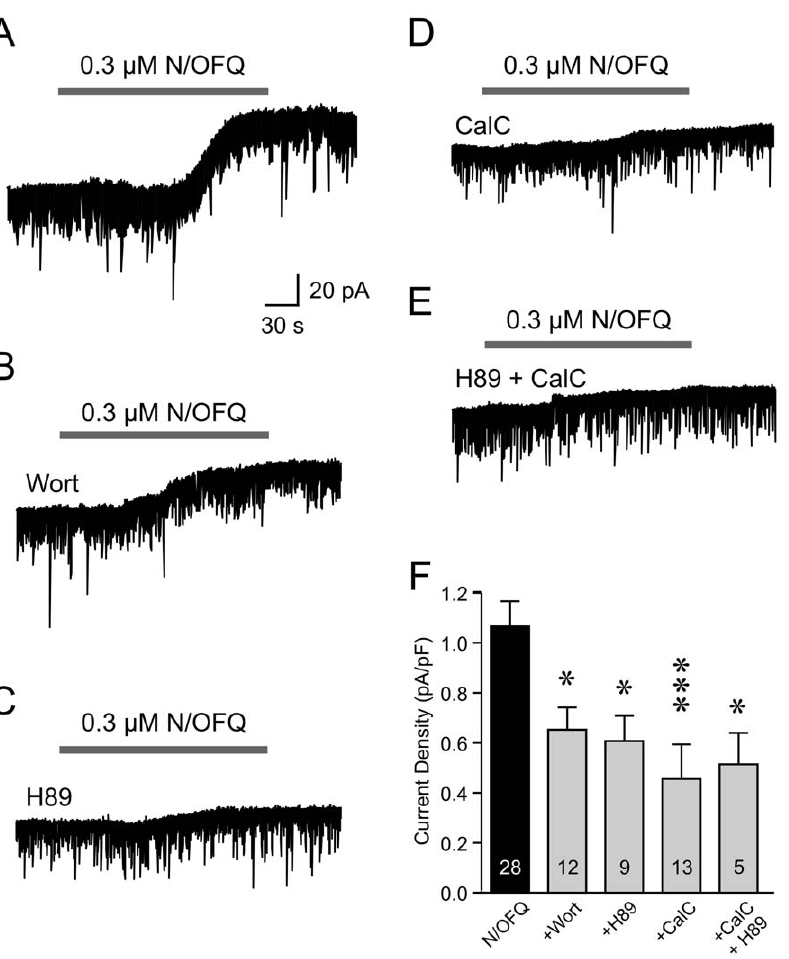
Figure 4. N/OFQ-induced KATP channel activation is mediated by PI3K, PKA and PKC. A-E : Representative recordings showing the effect of N/OFQ in the presence of specific inhibitors for PI3K (wortmannin; Wort), PKA (H89) or PKC (calphostin C; CalC), as indicated. Scale bars in A apply to all traces. F : Grouped data showing that kinase inhibitors attenuate the N/OFQ effect. Combined application of H89 and CalC did not have an additive effect. Numbers in bars represent the number of cells examined in each group. * p , 0.05, *** p , 0.001 vs.